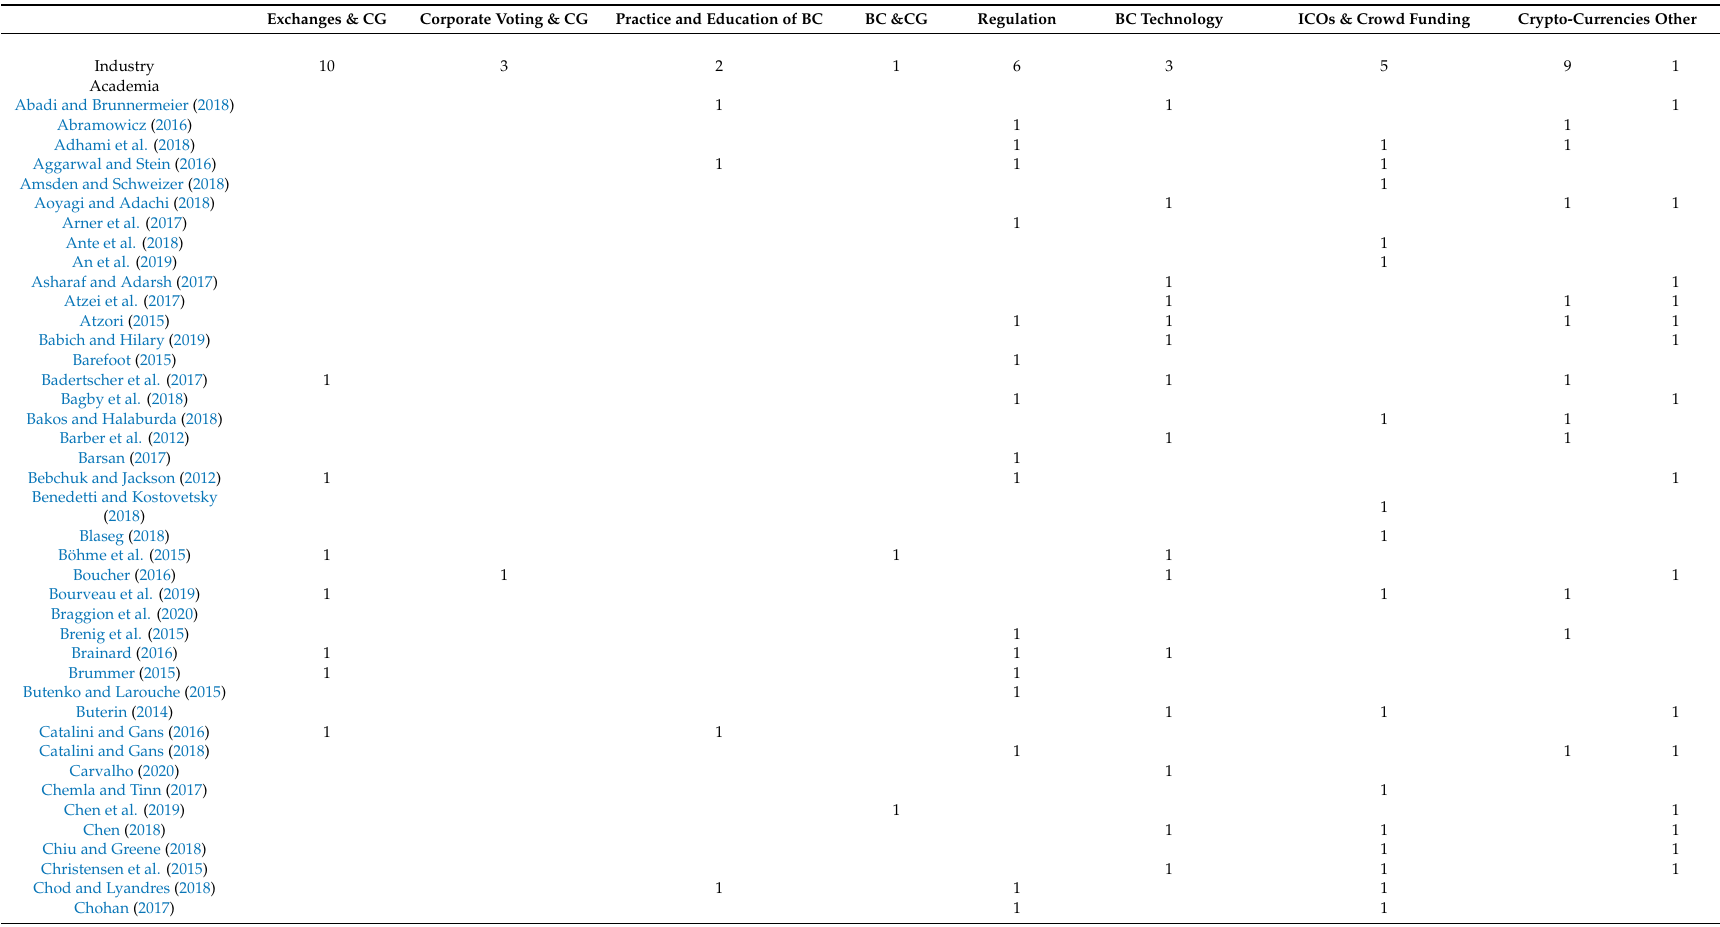
Table A1. Comparison of literature between industry, academic studies and professional